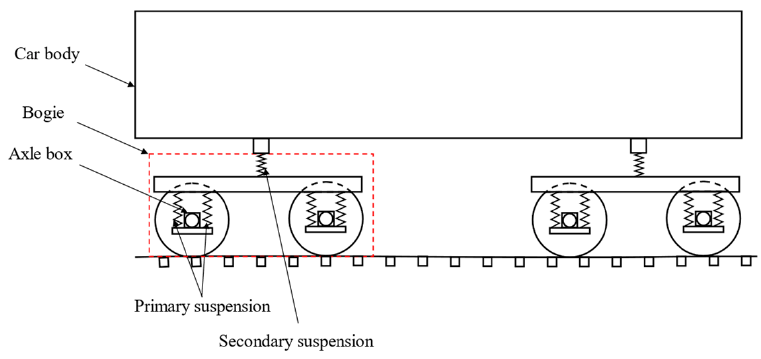
Figure 2. Schematic of rail vehicle suspension.